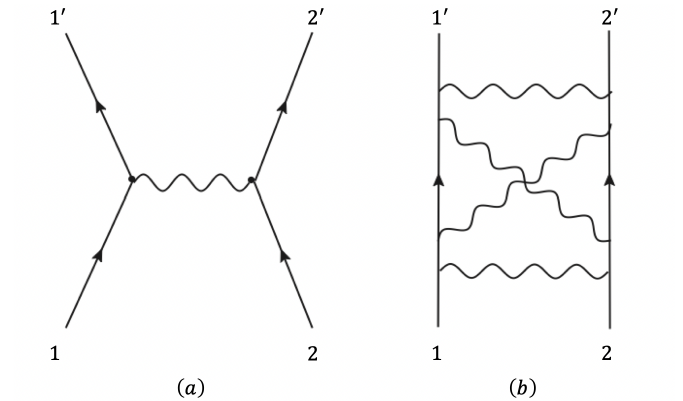
Figure 1 . (a) The tree level amplitude which contributes to leading order in Newton constant G . (b) The eikonal amplitude which resums all ladder